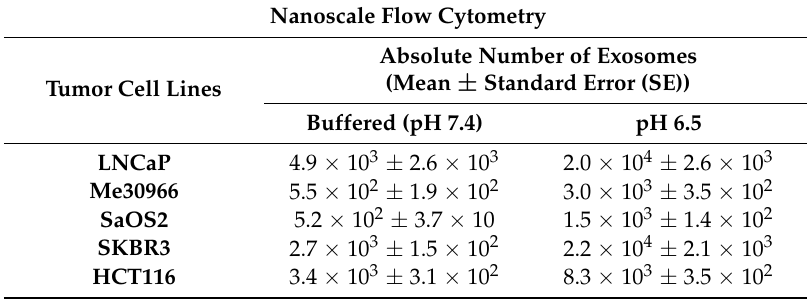
Table 1. Absolute number of CD9 + /CD81 + exosomes in tumor cells cultured in buffered (pH 7.4) and pH 6.5 conditions by Nanoscale Flow Cytometry.